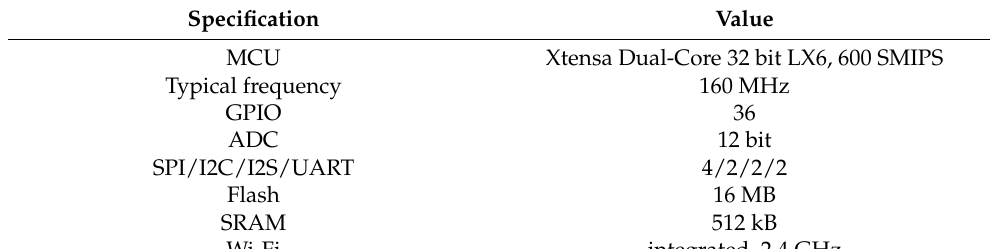
Table 1. ESP-32 specifications.